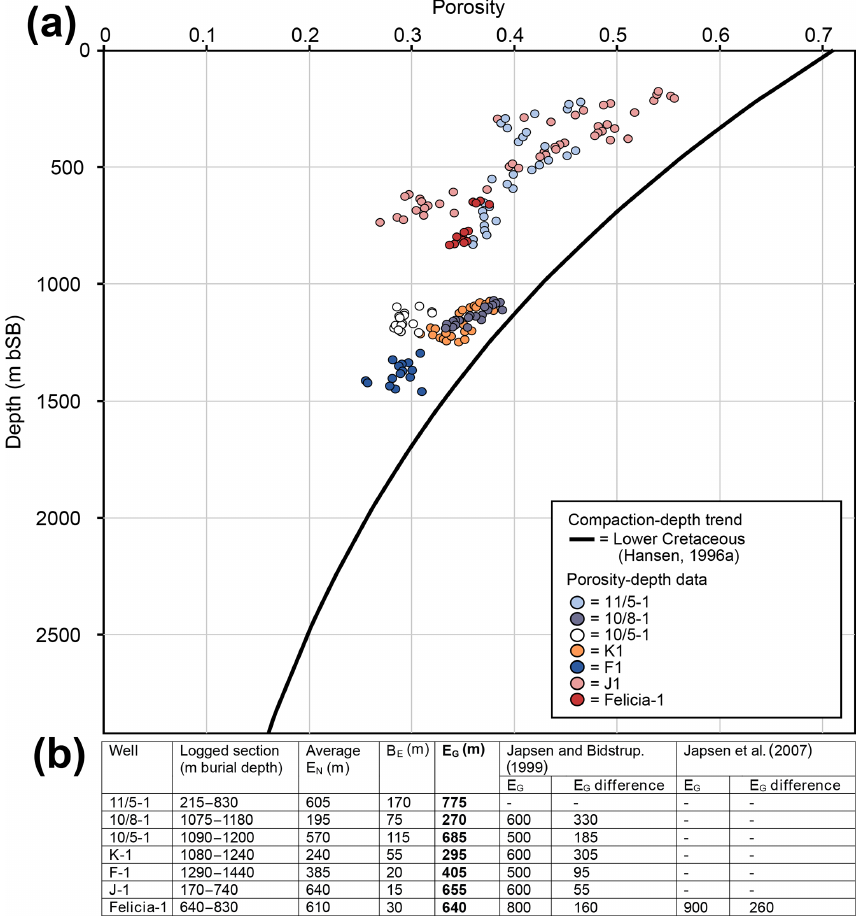
Figure 6. (a) Lower Cretaceous porosity–depth data from seven wells in the region, including one from the Farsund Basin (11/5-1). Depth measured in metres below seabed (m bSB). A normal compaction curve for Norwegian Shelf Lower Cretaceous shales is also shown (Hansen, 1996). (b) Estimates of net exhumation ( E N ) and gross exhumation ( E G ), which takes into account the vertical thickness of supra-Pleistocene unconformity sediments ( B E ). Also shown are values of E G from earlier studies using different stratigraphic intervals from several of the same boreholes. The difference between these estimates of E G and those calculated in this study are shown ( E G difference). See Fig. 2 for the locations of each of the wells.